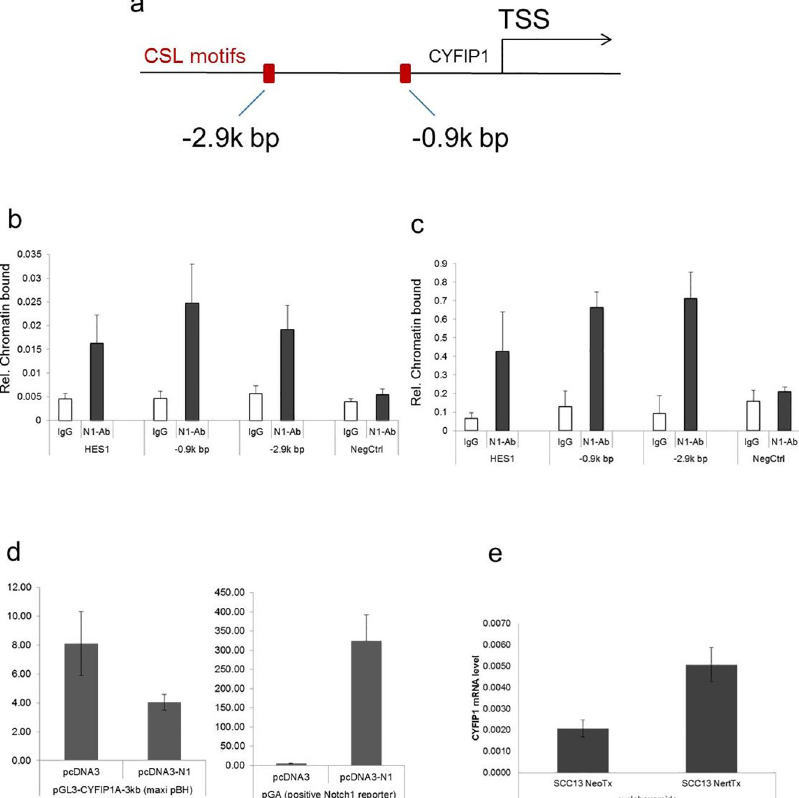
Fig 3. Endogenous Notch1 binds to the CYFIP1 locus within specific regions of chromatin organization. (a) Schematicillustrationof ChIP results: TSS–transcription starting site, CLS-bindingmotifs are representedby the red bars. (b) Human primary keratinocytes and (c) total epidermisextracts of human epidermis were processedfor ChIP assays using an antibodyspecific for Notch1, utilizingnon-immune IgGs as control. PCR amplification of the various regions of the human CYFIP1 promoterencompassed the followingCSL-bindingsites: -2.9k bp: 5’-GAGGTGGGAACTA-3’ ;-0.9k bp: 5’-AATGTGAGAAAGT-3’ . Un- precipitated chromatinpreparations were similarly analyzedand used as “input DNA” control. The nucleotide sequenceof the PCR primers is given in the materialsand methods. The results are representative of two independent experiments. The relativeamount of precipitatedDNA, expressed in arbitrary units, was calculatedafter normalization for total input chromatin, accordingto the followingformula (Frank et al. 2001): % total = 2 deltaCt x 5 where detaCt = Ct (input)–Ct (immunoprecipitation). Ct, cycle threshold. (d) 3 kb CYFIP1 promotorsequencewith the two putative NOTCH1 bindingsites was cloned and used for the luciferase activity assay. Increasedluciferase activity was observed in responseto NOTCH1 overexpression in the positive control (pGA), but not in the cells with the cloned CYFIP1 promotor. (e) To address the question of direct CYFIP1 regulationby Notch1 a further experiment with the protein synthesis inhibitor–cyclohexamide was used. Briefly, NeoNERTcells overexpressing Notch1 protein bound to the estrogen receptorwhere treated with cycloheximide to block any further protein synthesis. With the additionof tamoxifen, preexisting Notch1 was activated within the NeoNERT cells. This maneuverinducedan increasein CYFIP1 mRNA expression, provingthe direct nature of the bindingof Notch1 to the CYFIP1